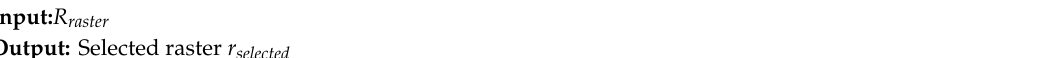
Algorithm 3: The RandomSelect algorithm